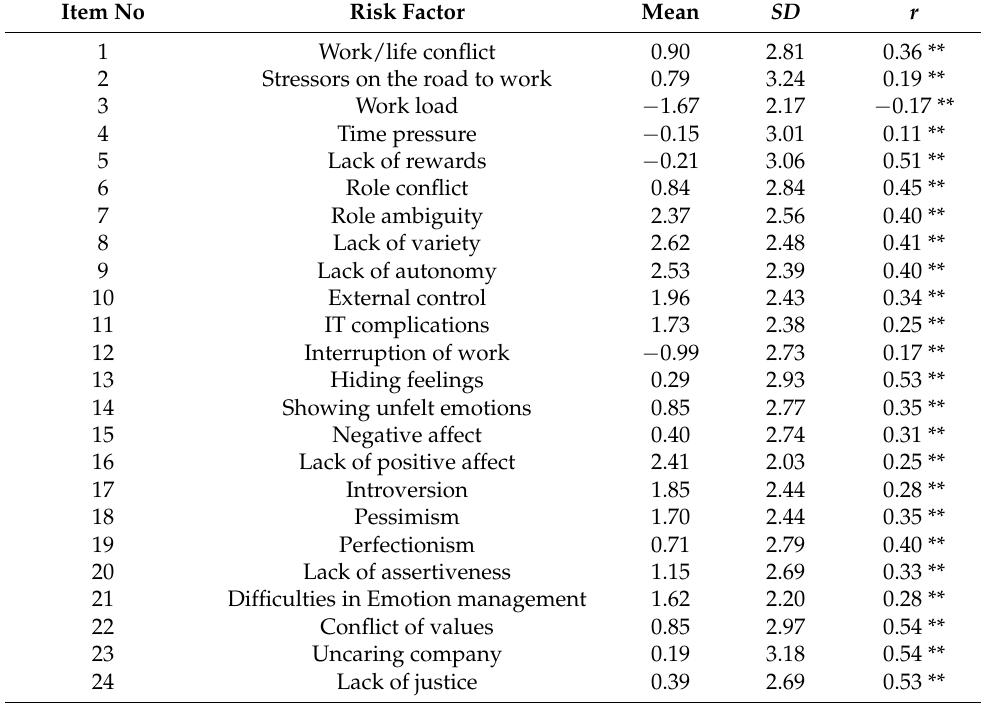
Table 2. Descriptive statistics of items and their correlations with the